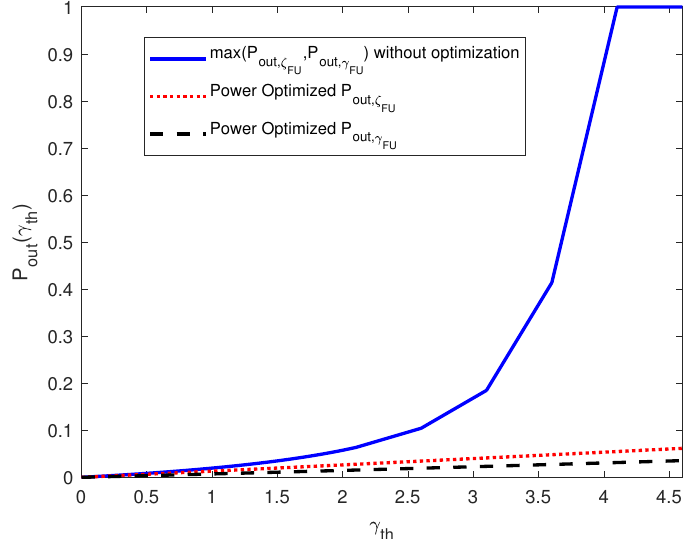
Figure 5. Performance of outage probability constraint for far user.